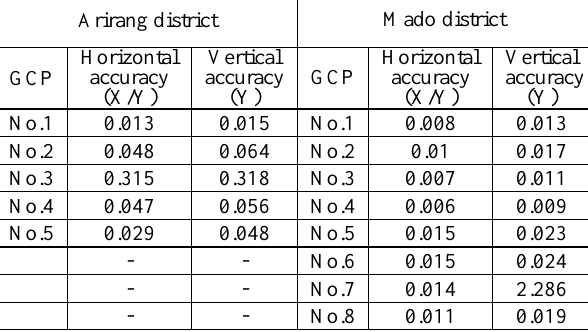
Table 3. Accuracy of GCPs survey each study site